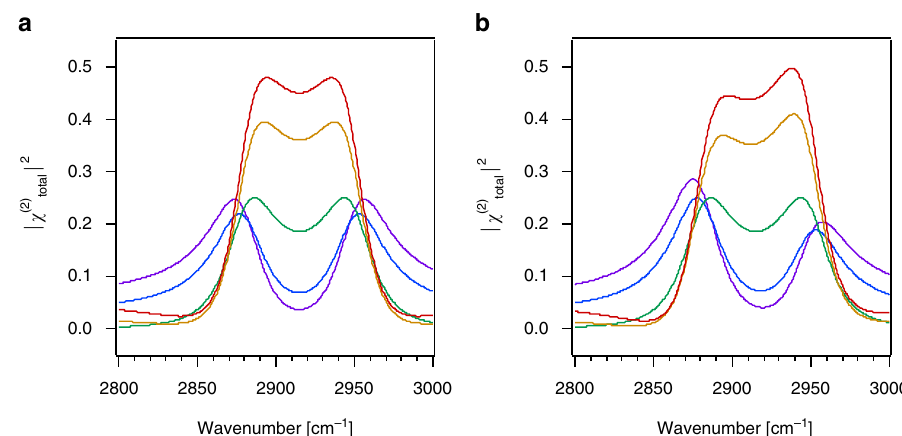
Fig. 2 Dual oscillators. SFG intensity spectra of two oscillators on a surface simulated for ω 1 = 2880 cm − 1 , γ 1 = 0°, ω 2 = 2950 cm − 1 , γ 2 = 180°, A v M v = 10, Γ = 20 cm − 1 , χ (3) = 1, and Φ (0) = − 240 mV (purple), − 170 mV (blue), < 1 mV (green), + 170 mV (orange), and + 240 mV (red), with an ionic strength of v 1 mM, calculated without a and with b absorptive-dispersive interactions